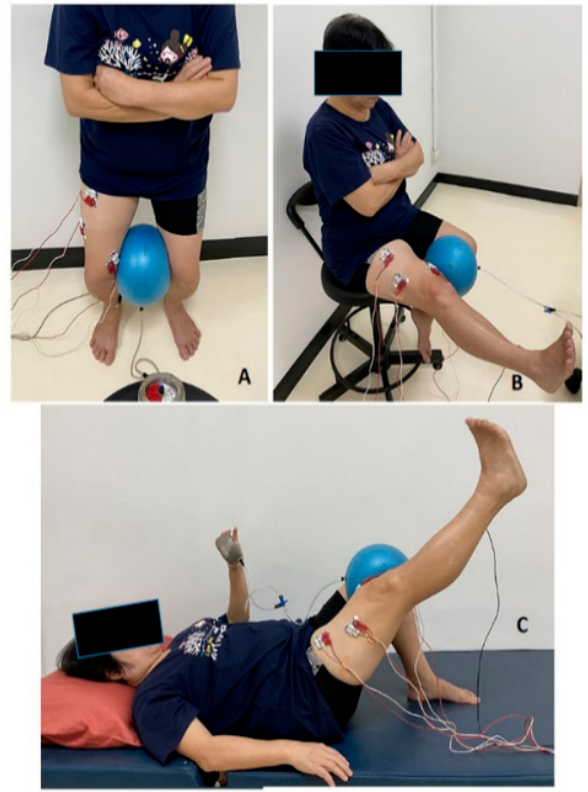
Figure 2. The squat ( A ), knee extension ( B ) and straight leg raise ( C ) exercises with hip adductor co- contraction.